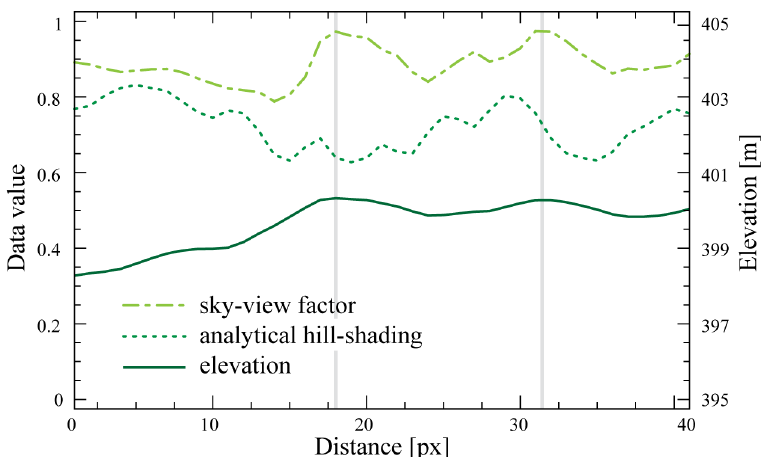
Figure 7. A 20 m long profile of DEM created from laser scanning data over the archaeological site at Tonovcov grad (Slovenia); see Figure 8 for the profile position. We compare values of SVF (range 0 to 1), analytical hill-shading (cosine of incidence angle, 0 to 1) and elevation (395 to 405 m). We also tested transects extending in other directions to consider the effect of directional illumination, but the results of analytical hill-shading were always noisier than the